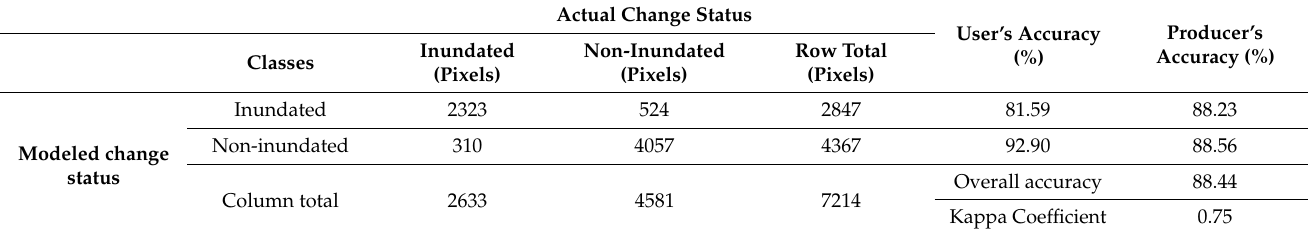
Table 2. Accuracy assessment result using the confusion